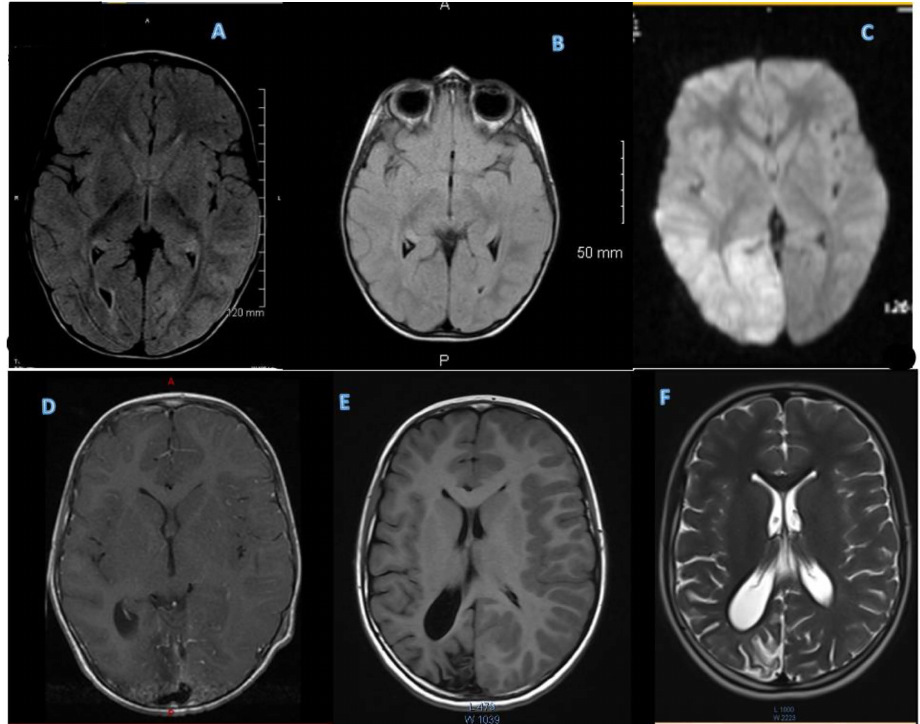
Figure 2. ( A ) Two years and 4 months (3rd attack—1st with hemiplegia) showed medial left temporal lobe edema (FLAIR imaging). ( B ) Two years and 5 months (no attack) normal (FLAIR imaging). ( C ) Diffusion-weighted imaging (DWI) at 3 years 9 months during 4th attack HM episode, showing increased signal in right occipital lobe. ( D ) Contrast-enhanced TI imaging at 4 years showing increased enhancement in right occipital lobe during 5th HM episode. ( E ) TI imaging at 7 years during 6th attack showing atrophy in right occipital lobe. ( F ) T2 imaging performed at 11 years during minor HM episode, demonstrating stable atrophy on the right occipital lobe without associated